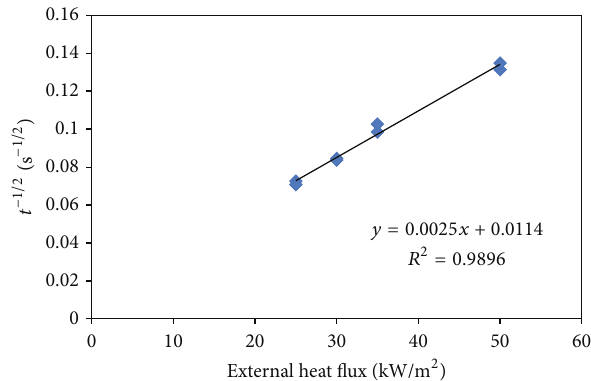
Figure 10: Thermal inertia of the neat epoxy